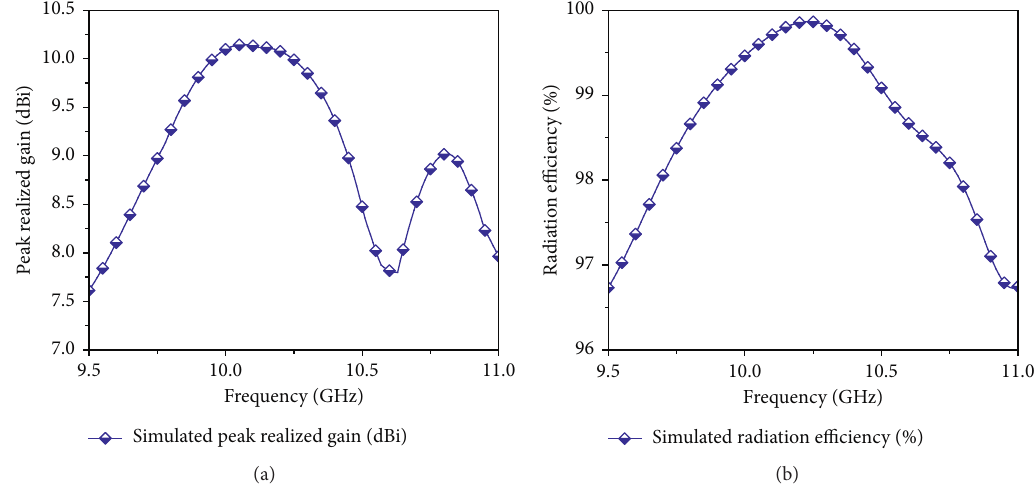
Figure 3: Simulated results. (a) Peak realized gain vs. operable frequency. (b) Radiation efficiency vs. operable